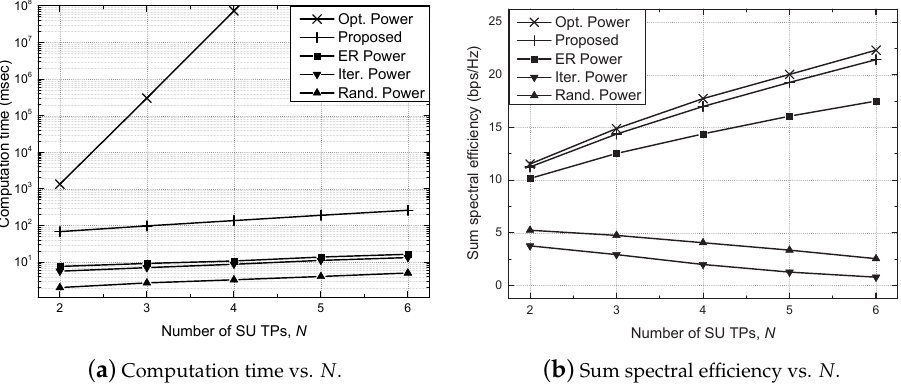
Figure 6. Performance comparison against the number of secondary user transceiver pairs (SU TPs) ( N